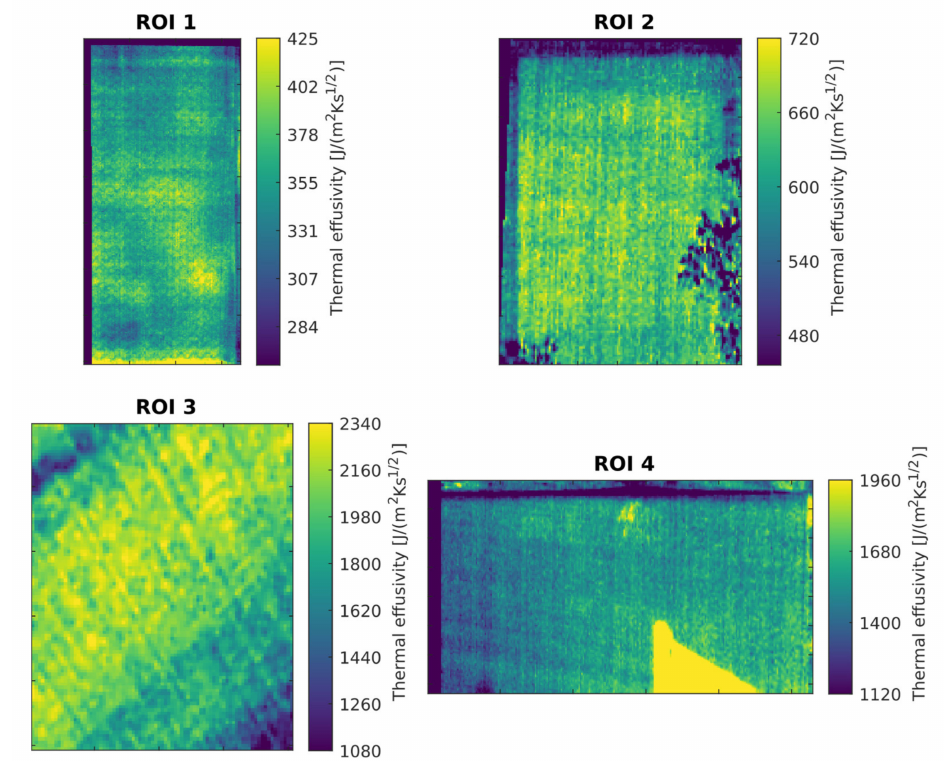
Figure 11. Perspective- and albedo-corrected LEF effusivity